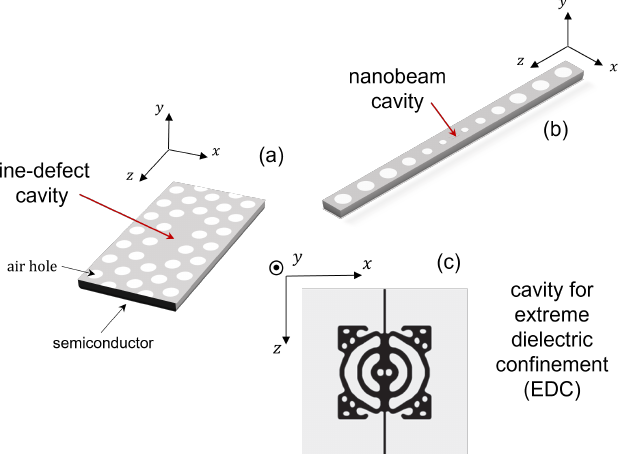
Figure 1. ( a ) Photonic crystal line-defect cavity, ( b ) photonic crystal nanobeam cavity and ( c ) a cavity for extreme dielectric confinement (EDC). In Figure 1c, the gray area is air and the black area is the semiconductor. Figure 1c is reprinted from [10], with the permission of AIP publishing,